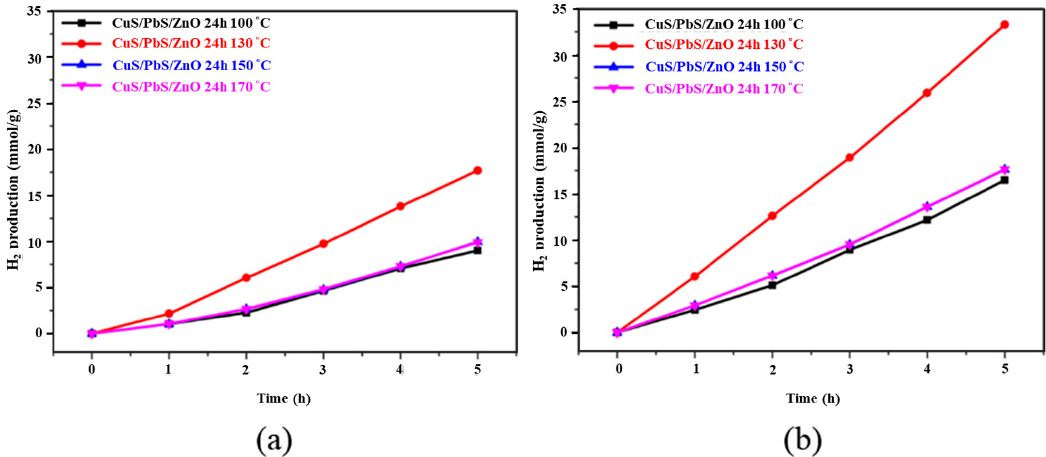
Figure 8. Analysis of hydrogen production in the presence of CuS/PbS/ZnO photocatalysts prepared at different hydrothermal temperatures. ( a ) No addition of Na 2 S and Na 2 SO 3 mixed sacrificial reagent. ( b ) Addition of 0.25 M Na 2 S and Na 2 SO 3 mixed sacrificial reagent.